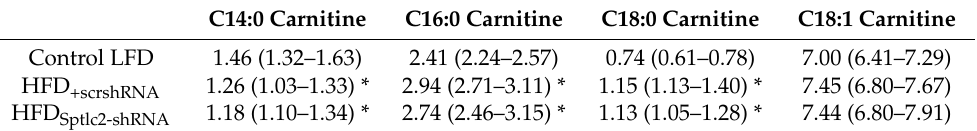
Table 6. The Impact of Sptlc2 Silencing on the Content of Acyl-Carnitine in the Mouse Gastrocnemius Muscle.